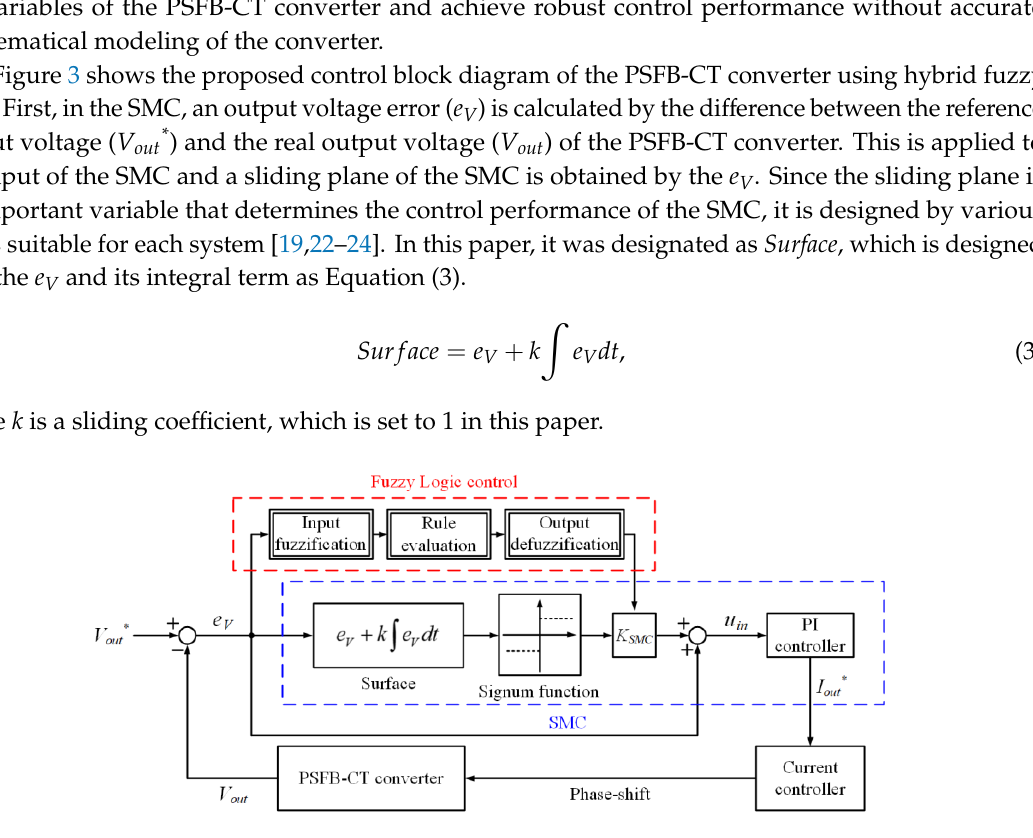
Figure 3. Proposed control block diagram of the PSFB-CT converter using hybrid fuzzy SMC.